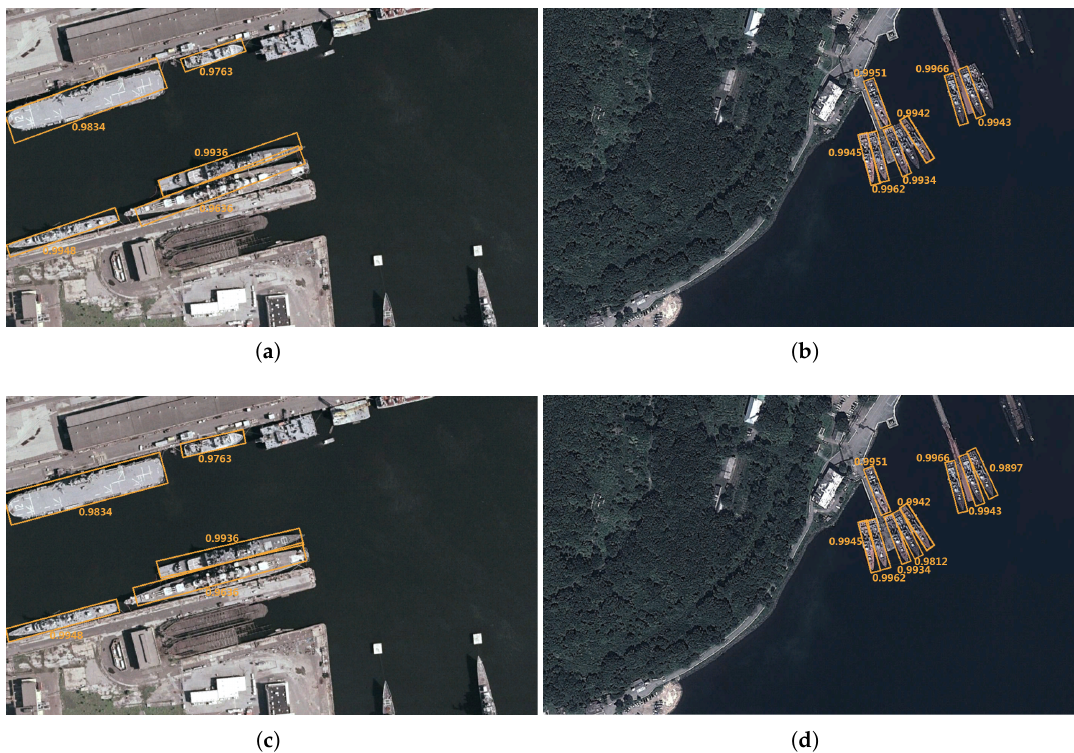
Figure 14. ( a , b ) detection results whose angles are predicted by neural network direct regression; ( c , d ) detection results whose angles are obtained through agent